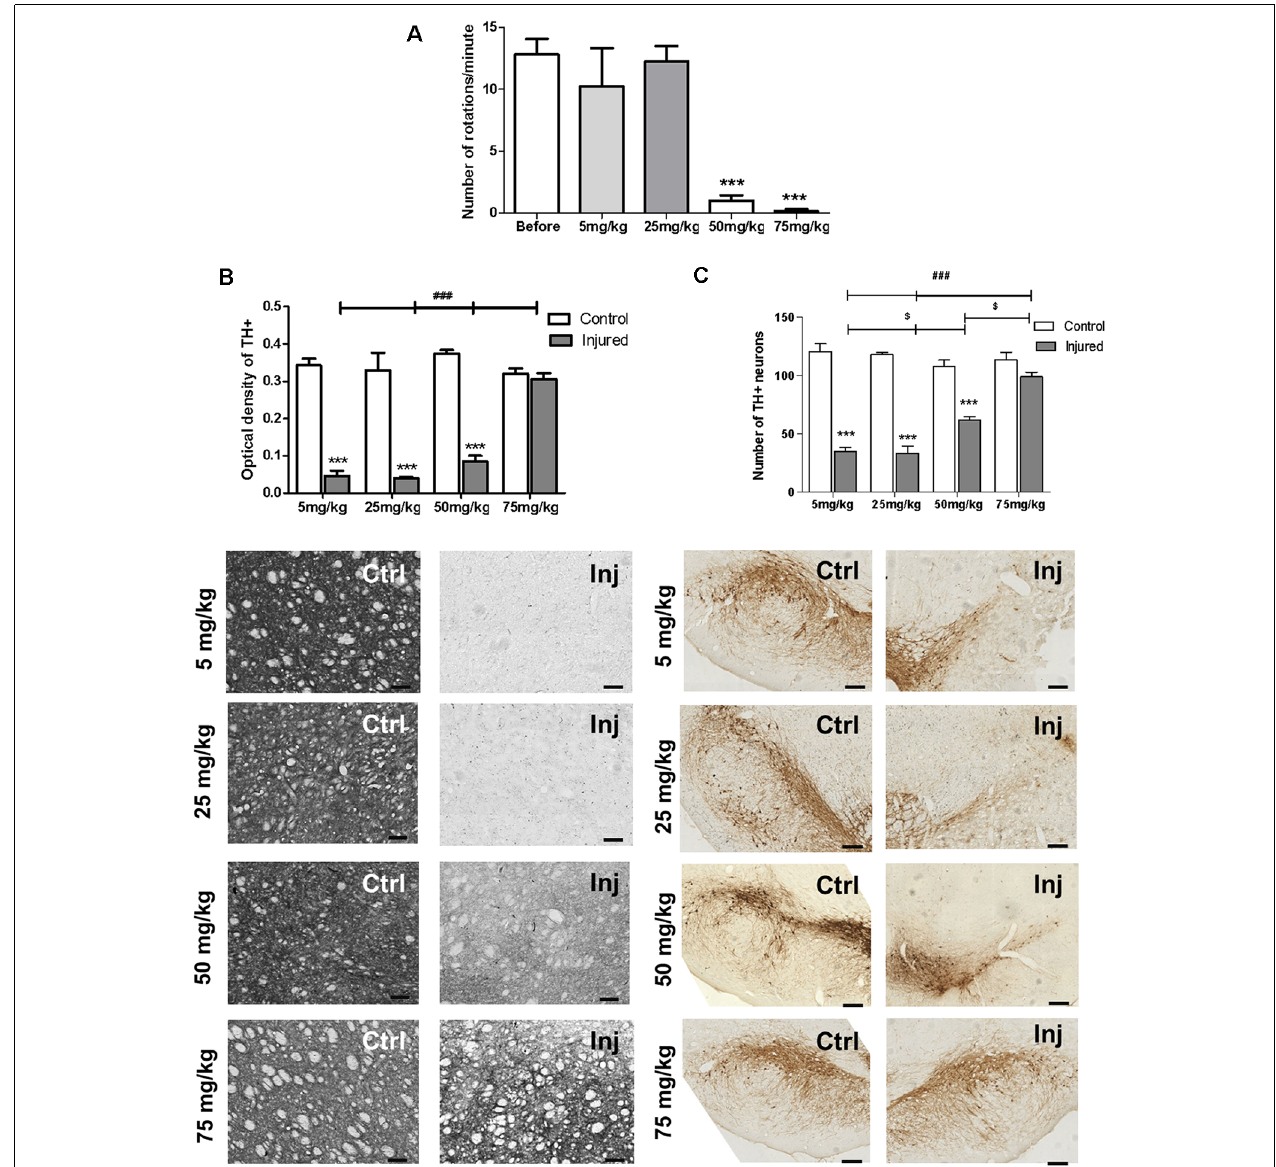
FIGURE 3 | Neuroregenerative effects of BBG treatment in 6-OHDA-injured rats. BBG at 5, 25, 50 and 75 mg/kg doses was administered during 7 days starting 1 week after injury induction by 6-OHDA (7 µ g/kg). (A) Animals were submitted to the apomorphine-induced rotational test before and after the treatment. ∗∗∗ p < 0.001 in relation to the number of pre-treatment rotations, n = 3–4; F ( 4,21 ) = 23.8528, p < 0.001. One-way ANOVA followed by the Tukey post hoc test. Immunohistochemical analysis of tyrosine hydroxylase labeling of the striatum (B) , measured as optical density of staining; scale bar: 100 µ m; n = 4 for BBG 5 and 25 mg/kg; n = 6 for BBG 50 and 75 mg/kg; F ( 3,32 ) = 30.262, p < 0.001. Tyrosine hydroxylase labeling of the substantia nigra (C) , expressed by number of neurons, scale bar: 200 µ m; n = 4 for BBG 5 and 25 mg/kg; n = 6 for BBG 50 and 75 mg/kg; F ( 3,32 ) = 23.266, p < 0.001. Control (Ctrl) and injured (Inj) hemispheres. Data are expressed as mean ± standard errors of the mean. ∗∗∗ p < 0.001 in relation to the respective control hemisphere; $ p < 0.05 injured hemisphere from BBG 50 mg/kg in relation to other injured hemispheres; ### p < 0.001 injured hemisphere from BBG 75 mg/kg in relation to other injured hemispheres. Two-way ANOVA followed by the Bonferroni post hoc